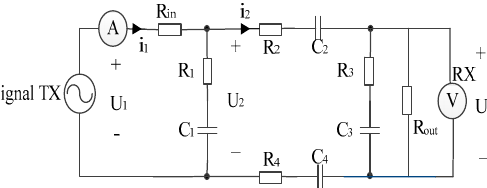
Figure 5. Equivalent circuit model of the circuit module in the field-circuit model, including the parasitic impedance between the transceiver electrodes, the internal impedances of the voltmeters and generators.